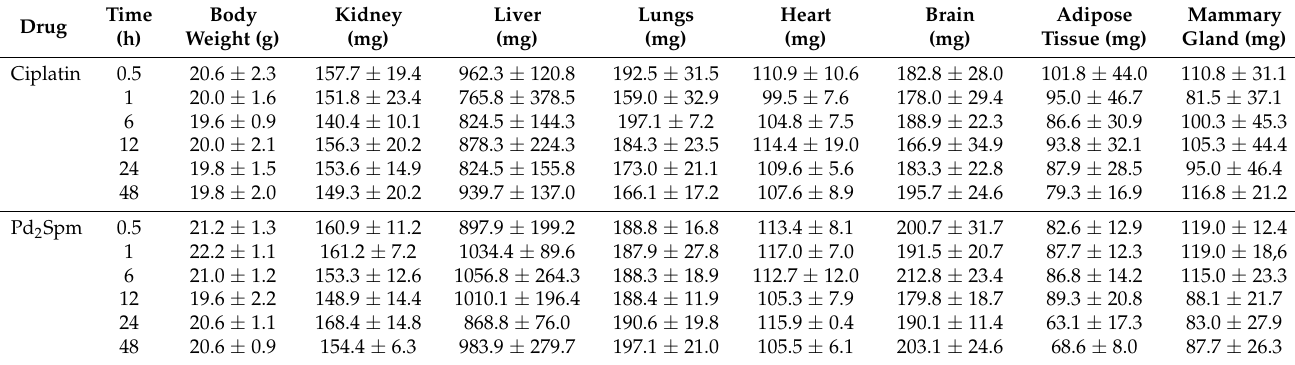
Table A1. The characterization of the study groups with the weights of animals and respective wet tissue weights.